Question: Which kind of chart has been used to present this data?
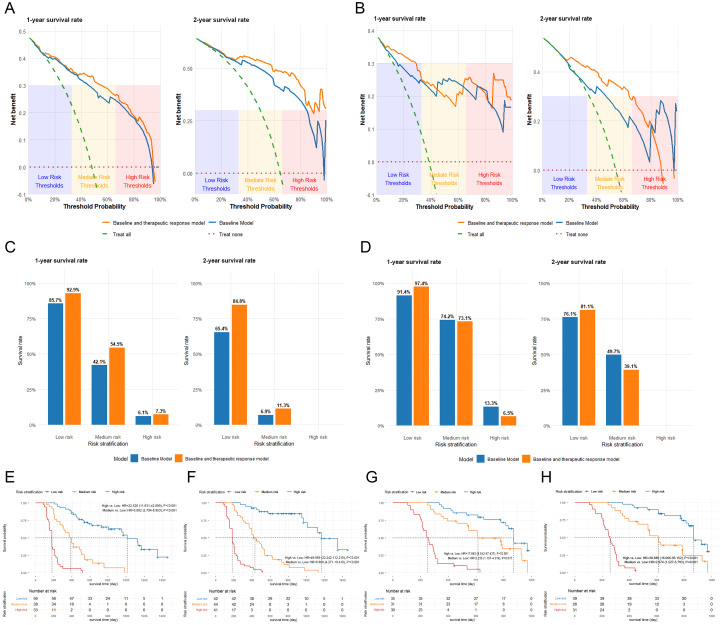
Answer: survival